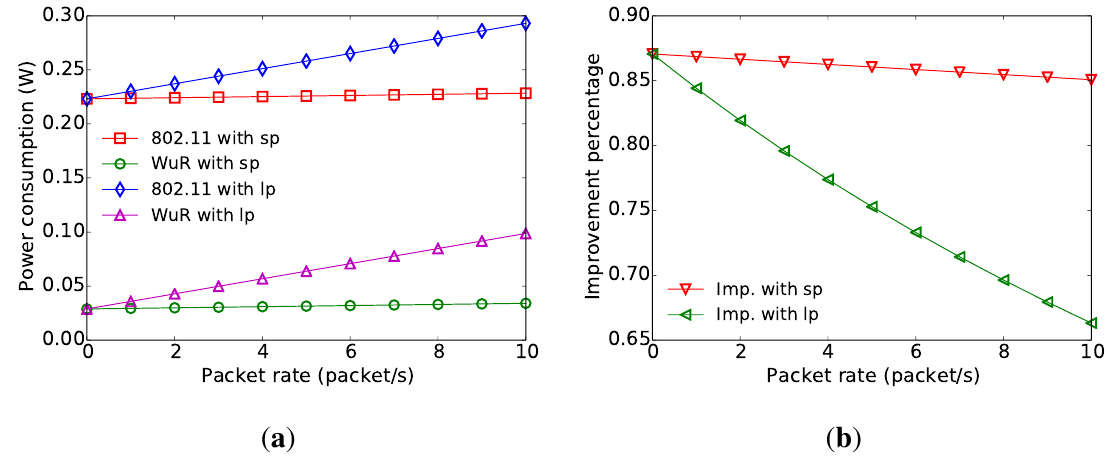
Figure 7. Power consumption is a function of packet rate. ( a ) Power consumption versus packet rate; ( b ) improvement on power consumption versus packet rate.